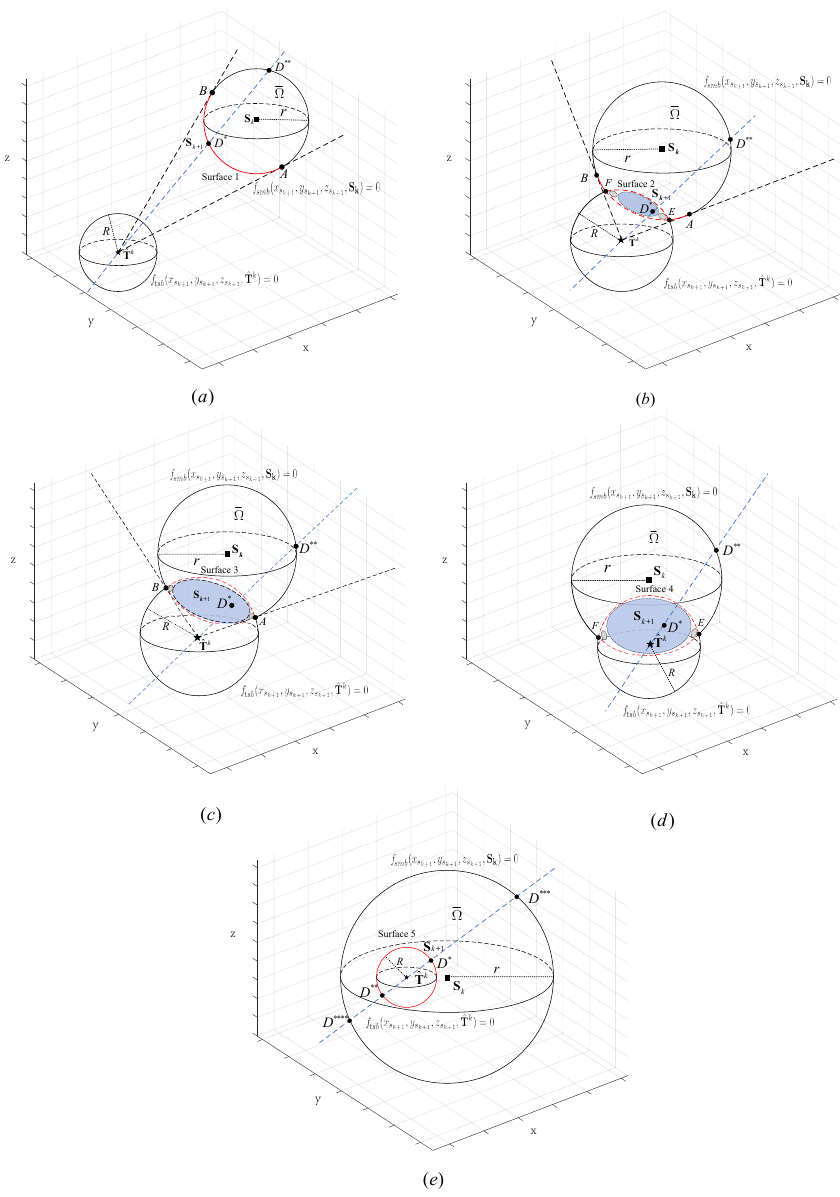
Figure 3. Surface 1 (red part in ( a )) when the two areas are separated, surface 2 (red part in ( b )), surface 3 (red part in ( c )) and surface 4 (red part in ( d )) when the two areas intersect, the target safety boundary (red part in ( e )) when the target safety area is in the sensor movement